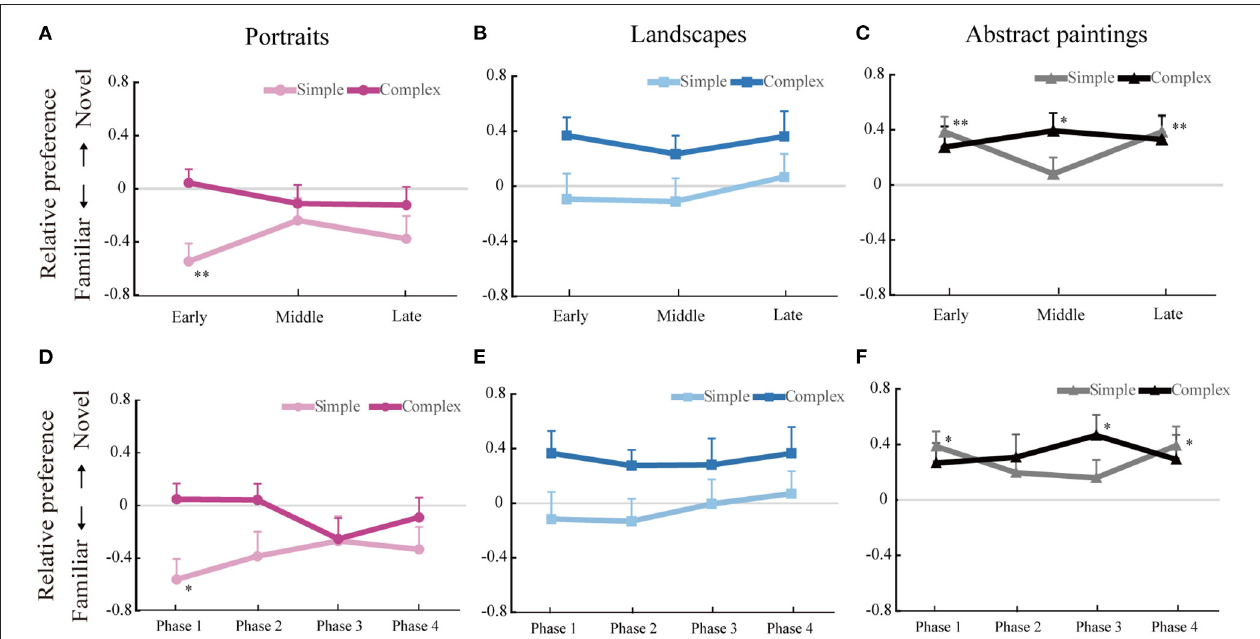
FIGURE 4 | Temporal changes in familiarity-novelty preference. All trials between the fourth and fifteenth trials were divided into three phases: early (4–7), middle (8–11), and late (12–15) phases for portraits (A) , landscapes (B) , and abstract paintings (C) . All trials between the fourth and fifteenth trials were also divided into four phases: phase 1 (4–6), phase 2 (7–9), phase 3 (10–12), and phase 4 (13–15) phases for portraits (D) , landscapes (E) , and abstract paintings (F) . The mean relative preference values for each phase are shown. The negative values of the y-axis indicate a preference for repeated (i.e., familiar) paintings, and the positive values of the y-axis indicate a preference for novel paintings. Error bars represent + 1 standard error of the mean. Asterisks indicate a significant difference from zero, as per the results of one-sample t -tests (* p < 0.05 and ** p <